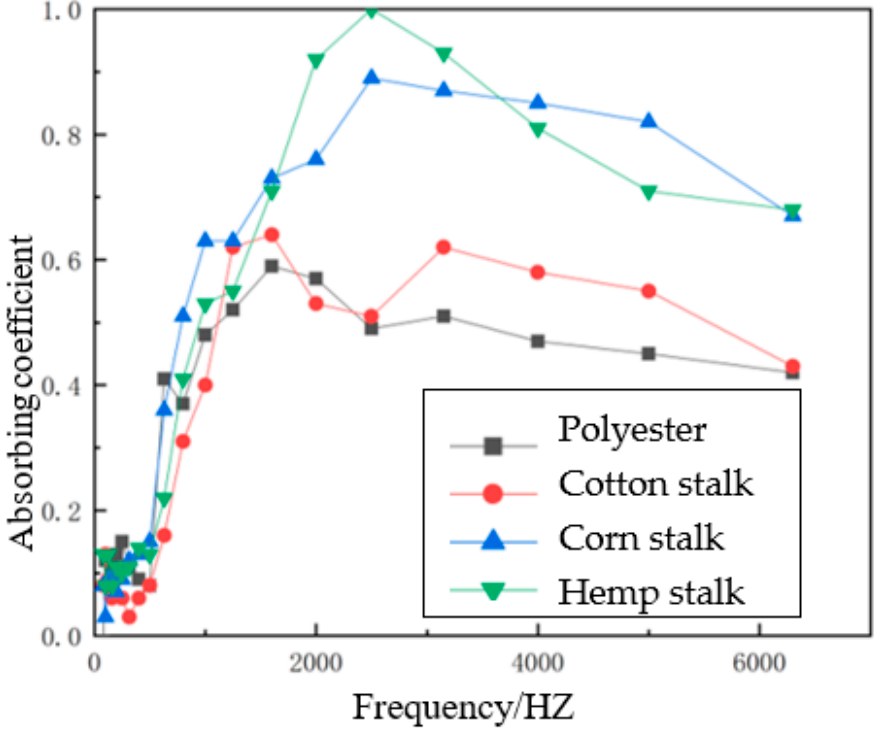
Figure 14. Sound absorption coefficient curve of different reinforcement materials.